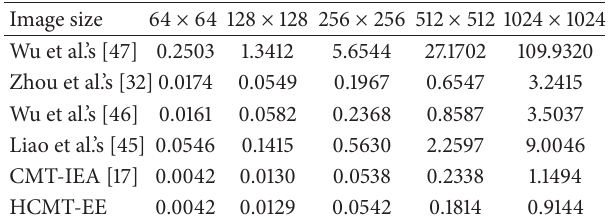
Table 1: Encryption speed (seconds) of various encryption algo-